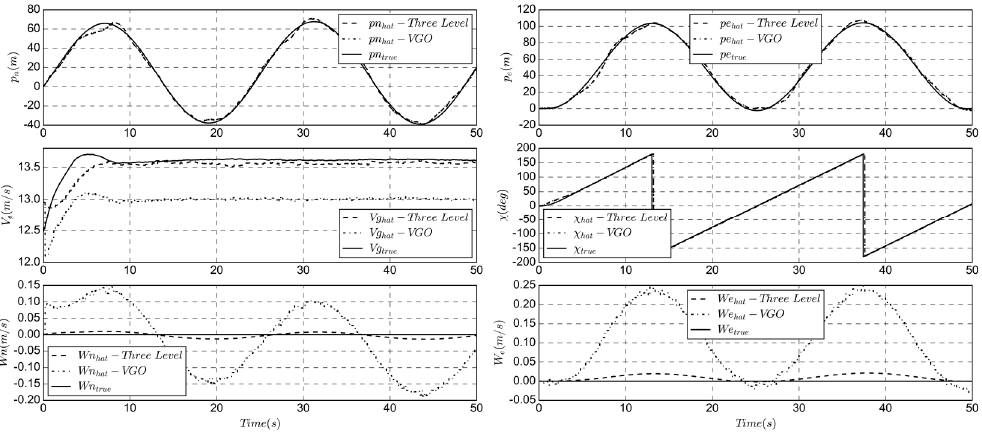
Figure 7. Comparison of true and estimated location, groundspeed and course. Algorithm 1. Three-stage series state estimation